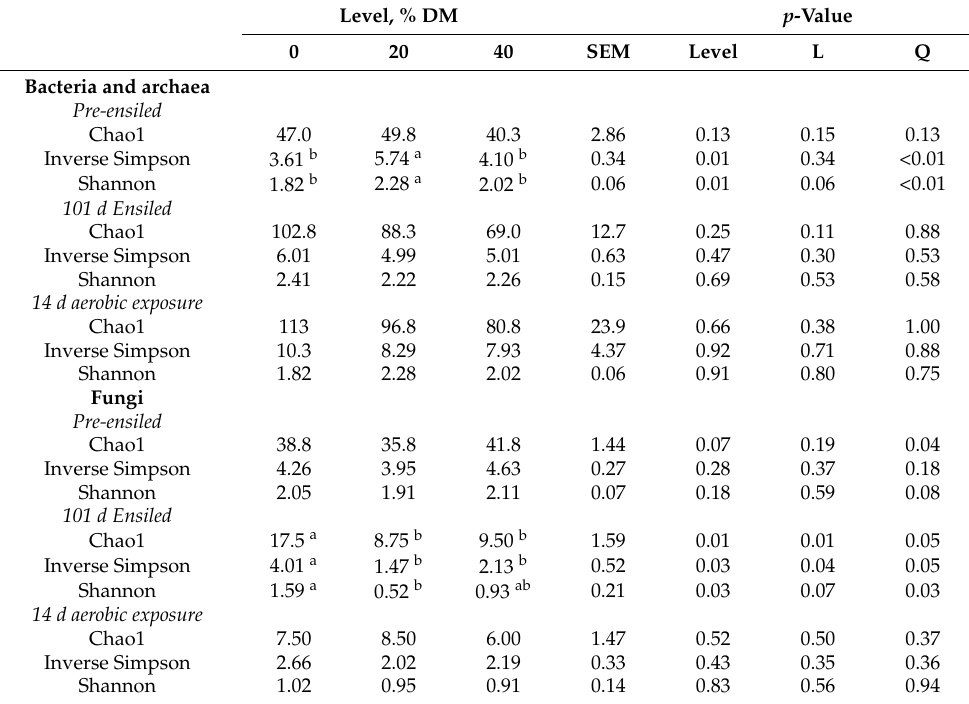
Table 3. Measures of alpha diversity for the bacterial, archaeal, and fungal communities of vegetable mix silages ensiled with 0, 20, or 40% DM vegetable mix pre-ensiled, 101 d ensiled, and after 14 d aerobic